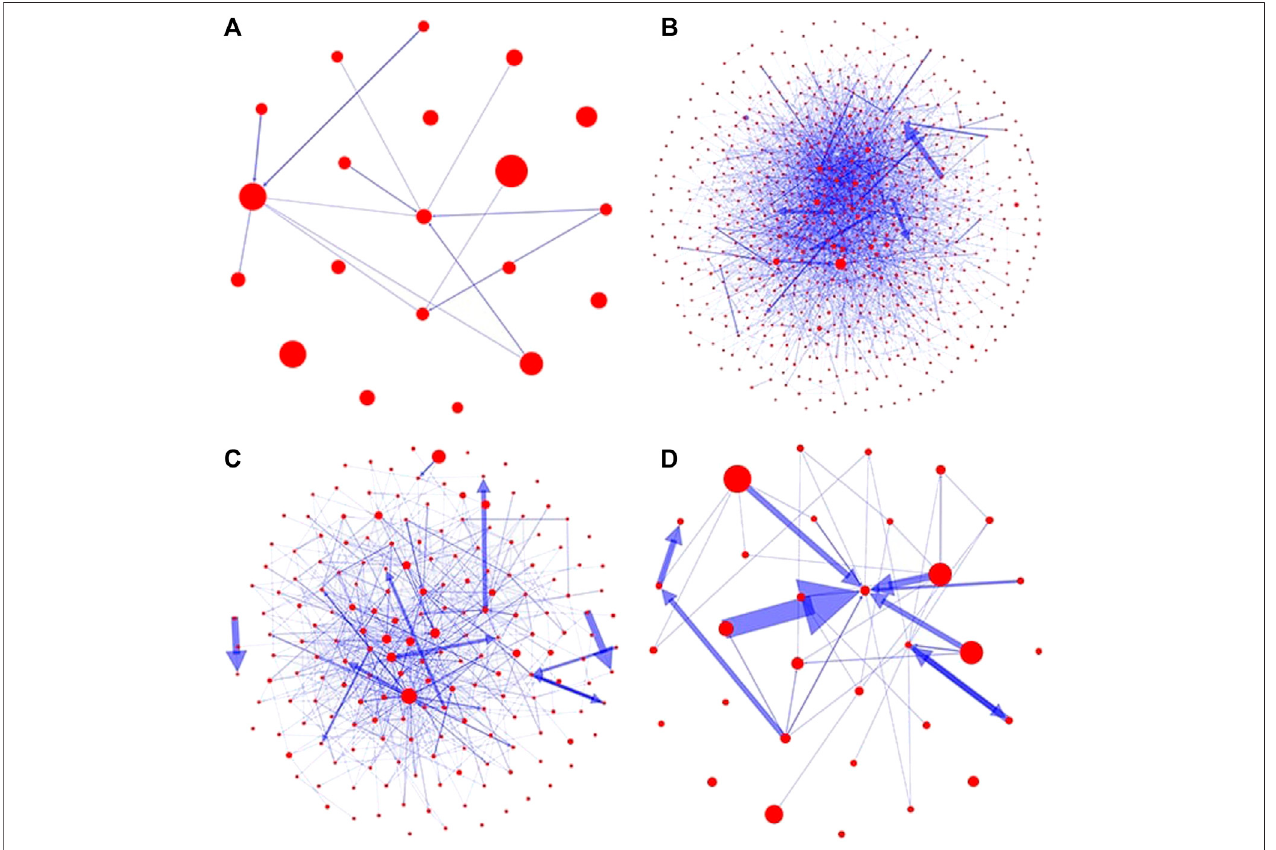
FIGURE3| Visualizationsoftypical networksineverystage.Nodesinthenetworkare fi lteredbyout-degree. (A) Therearen ’ tmanyearlyplayersinstage1. (B) The network contains a large number of nodes in stage 2. (C) The network shrinks in stage 3. (D) Only long-term players are left in stage 4.